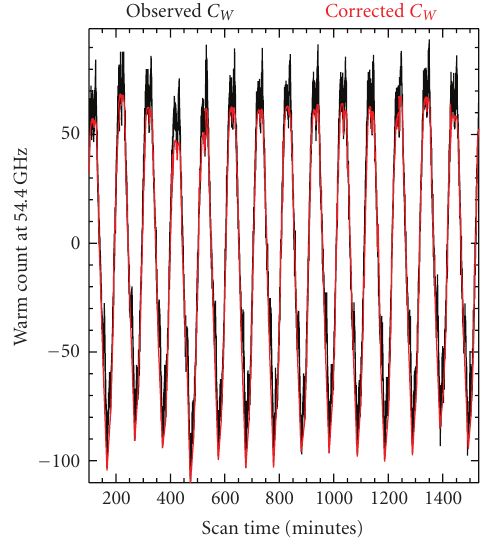
Figure 6: Time series of C Obs and corresponding C Cor at 54.4GHz W W for all orbits on August 15, 2006. In the figures, an orbital mean of corresponding counts has been subtracted from the warm counts in each orbit of